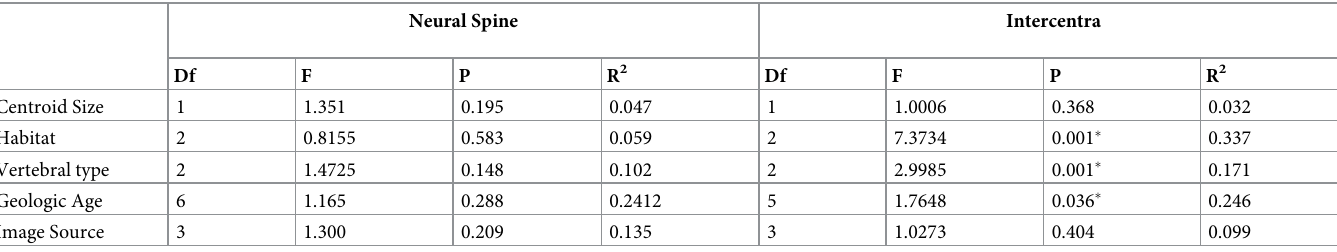
Table 2. Shape-ANOVA results.